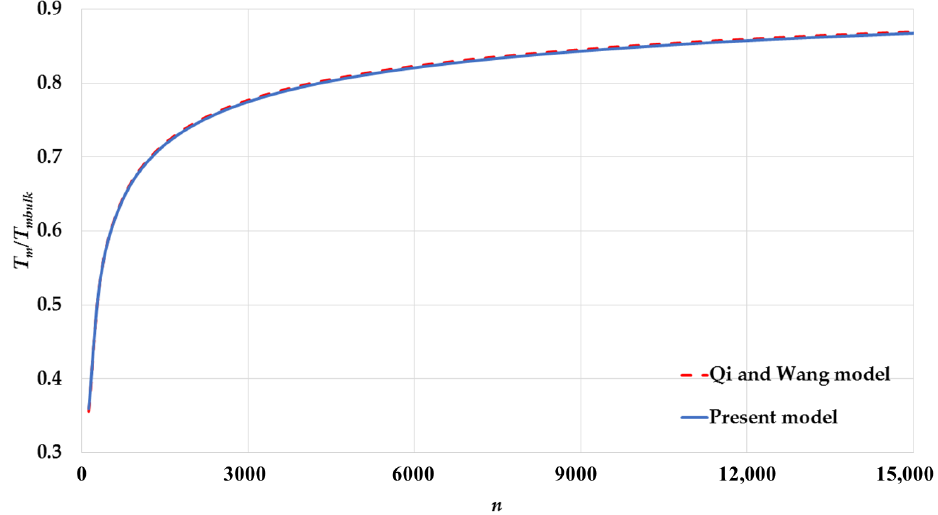
Figure 6. The variation of ratio 𝑇 𝑚 𝑇 𝑚𝑏𝑢𝑙𝑘 ⁄ as function of number of atoms 𝑛 of spherical nanoparticles in a BCC structure using the present model and compared to Qi and Wang model [24].